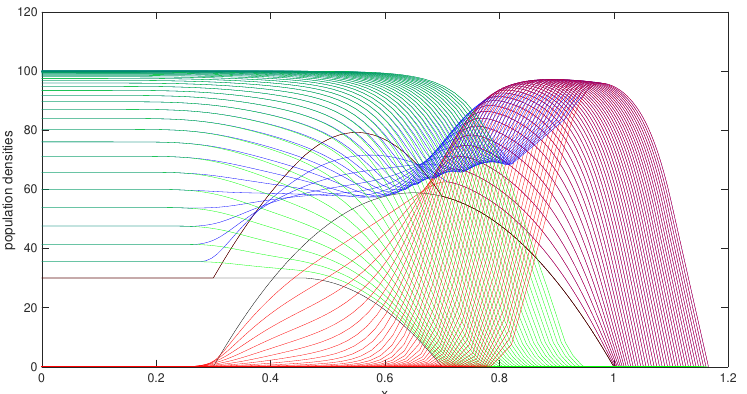
Figure 4. Result of the competition–diffusion model at t = 10. Here, we use δ 1 = δ 2 = 0.001, K 1 = 1, K 2 = 5, k 1 = k 2 = 100, r 1 = r 2 = 1, and µ = 50. Due to the high competition rate of species 1, species 2 is unable to compete.